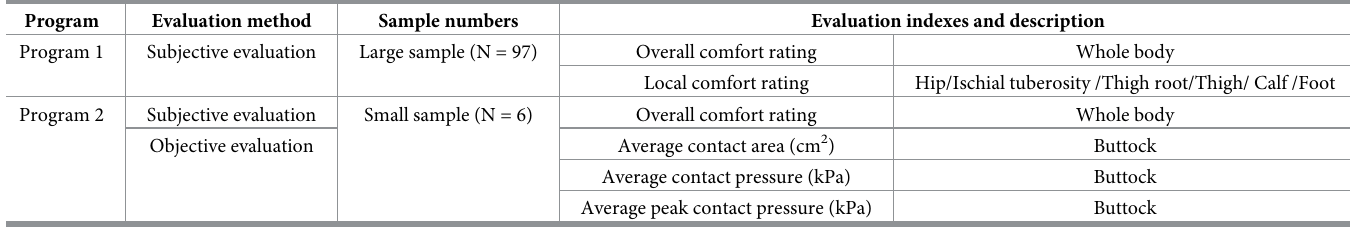
Table 1. Experimental protocol and sample